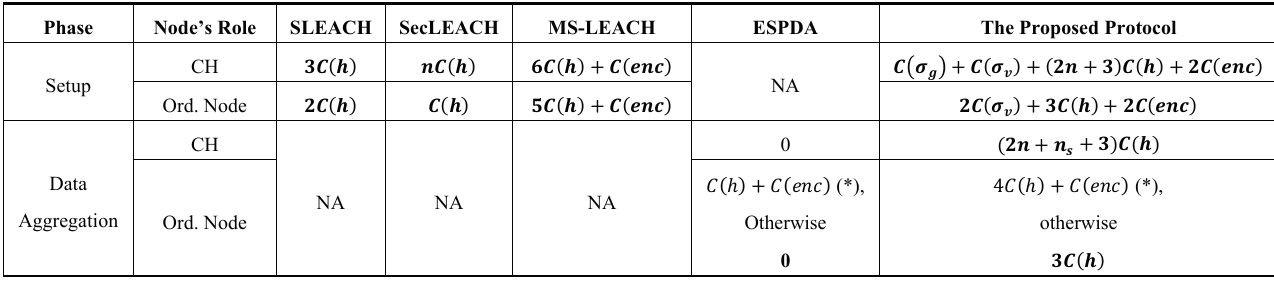
Table 15. Computational cost